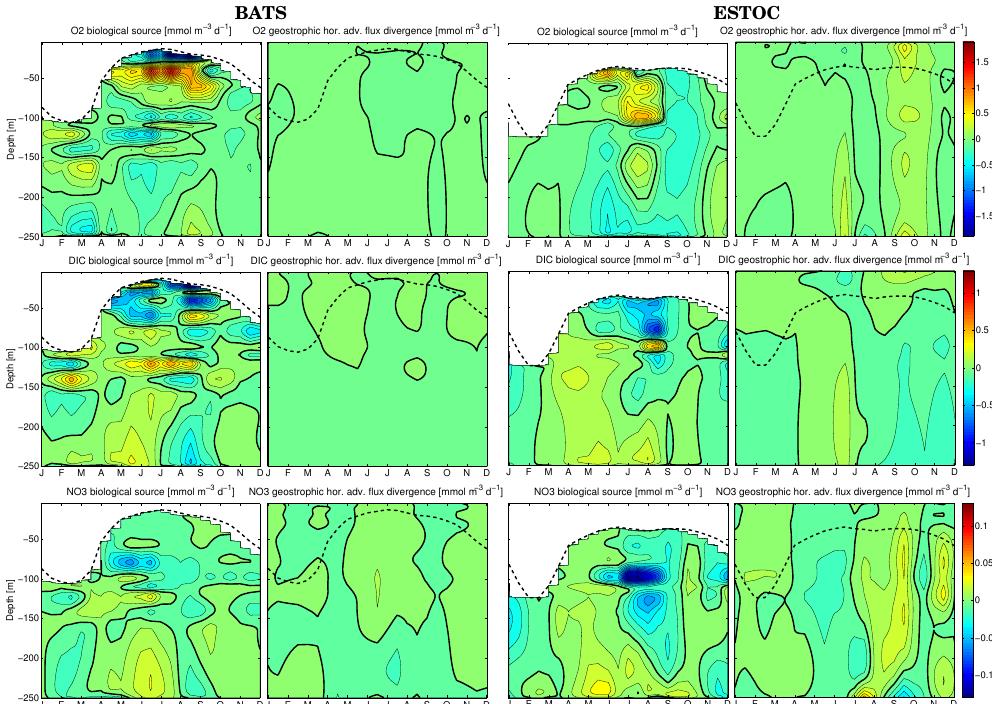
Fig. 6. Biological source term ( J C ) and geostrophic horizontal advection flux divergence computed for oxygen, DIC and nitrate at BATS and ESTOC. The discontinuous line represents the mixed-layer depth and the black thick line the zero isoline. Isoline separations are 0 . 1 mmol O 2 m − 2 d − 1 , 0 . 1mmolCm − 2 d − 1 and 0 . 01mmolNm − 2 d − 1 , for oxygen, DIC and nitrate,